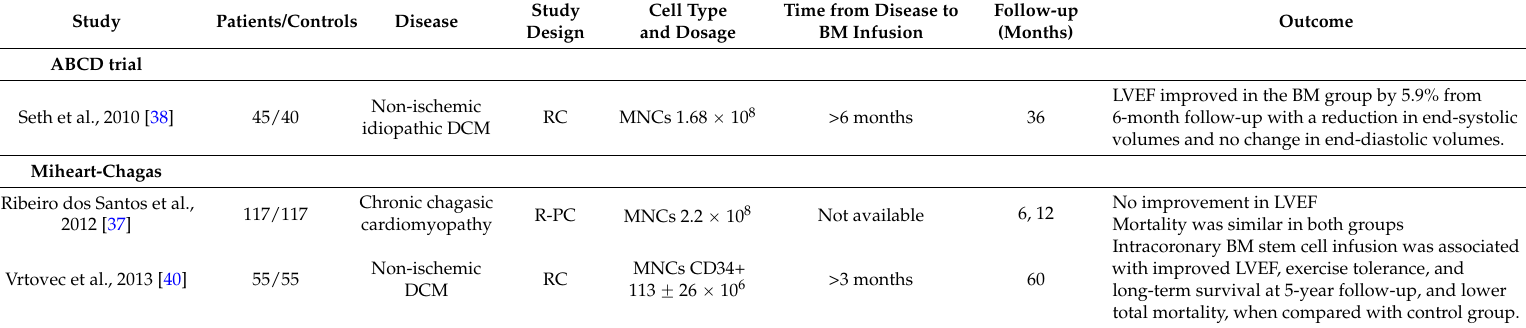
Table 3. Randomized controlled studies with bone marrow mononuclear cells for intracoronary delivery in adults with non-ischemic